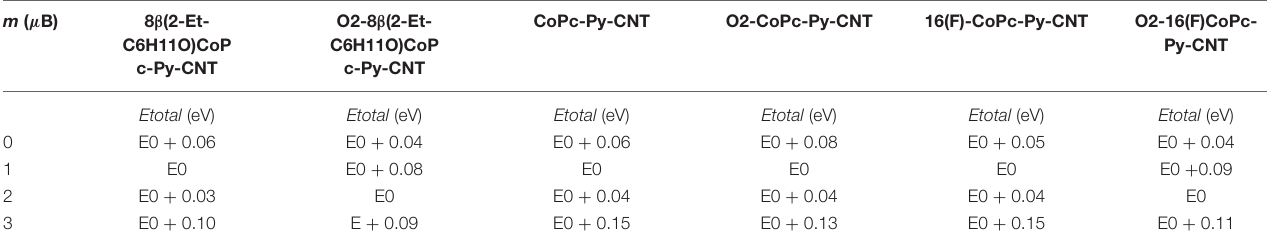
TABLE 1 | Resume of the total energy for 8(2-Et-C 6 H 11 O)CoPc-Py-CNT, CoPc-Py-CNT, and 16(F)-CoPc-Py-CNT with and without the O 2 molecule adsorbed on the Co metal center for the allowed spin states. m ( µ